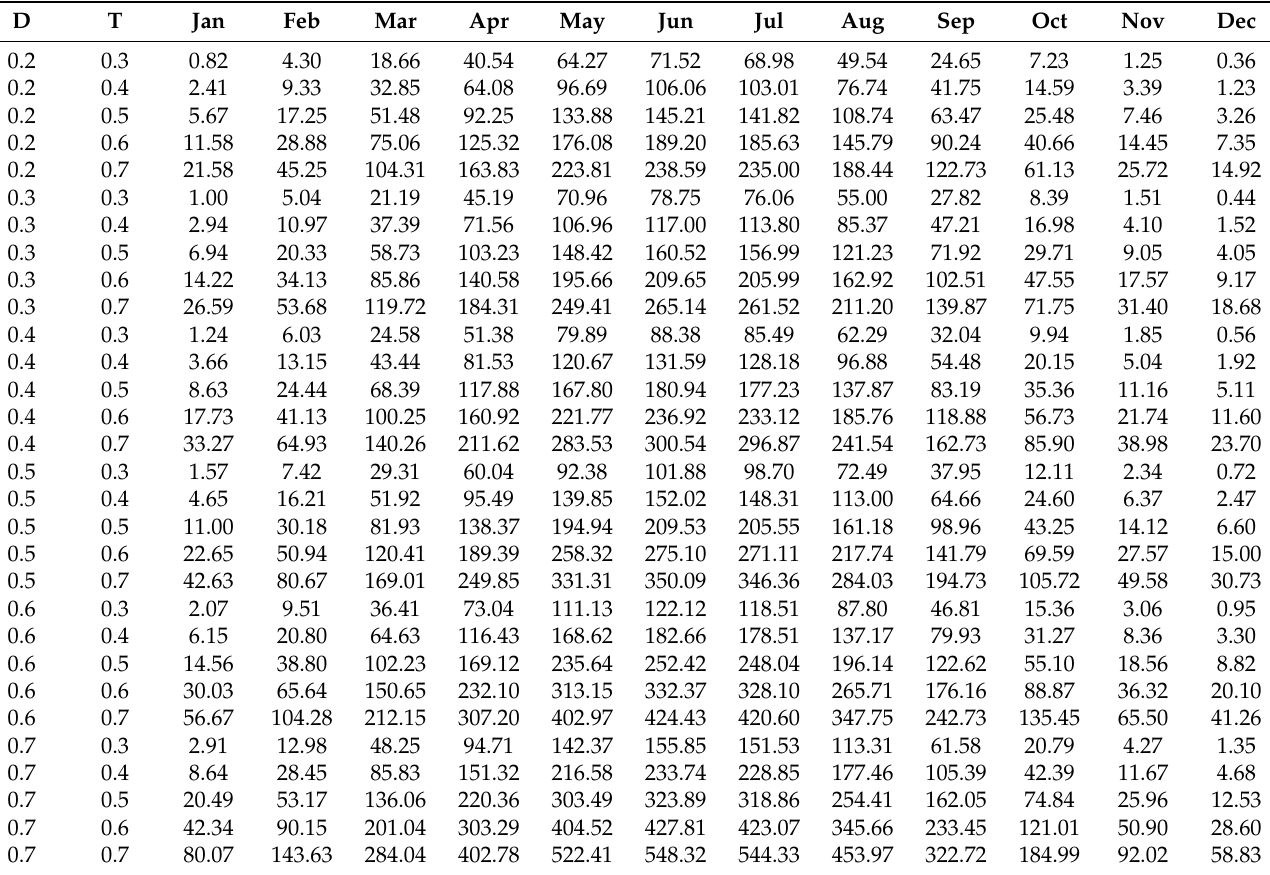
Table A2. Monthly modelled irradiation values for all combination of D and T at de Bilt using Solar Radiation tool.